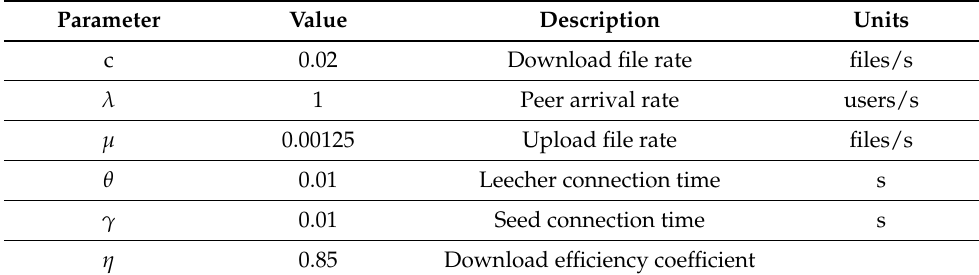
Table 2. Parameters used in the simple